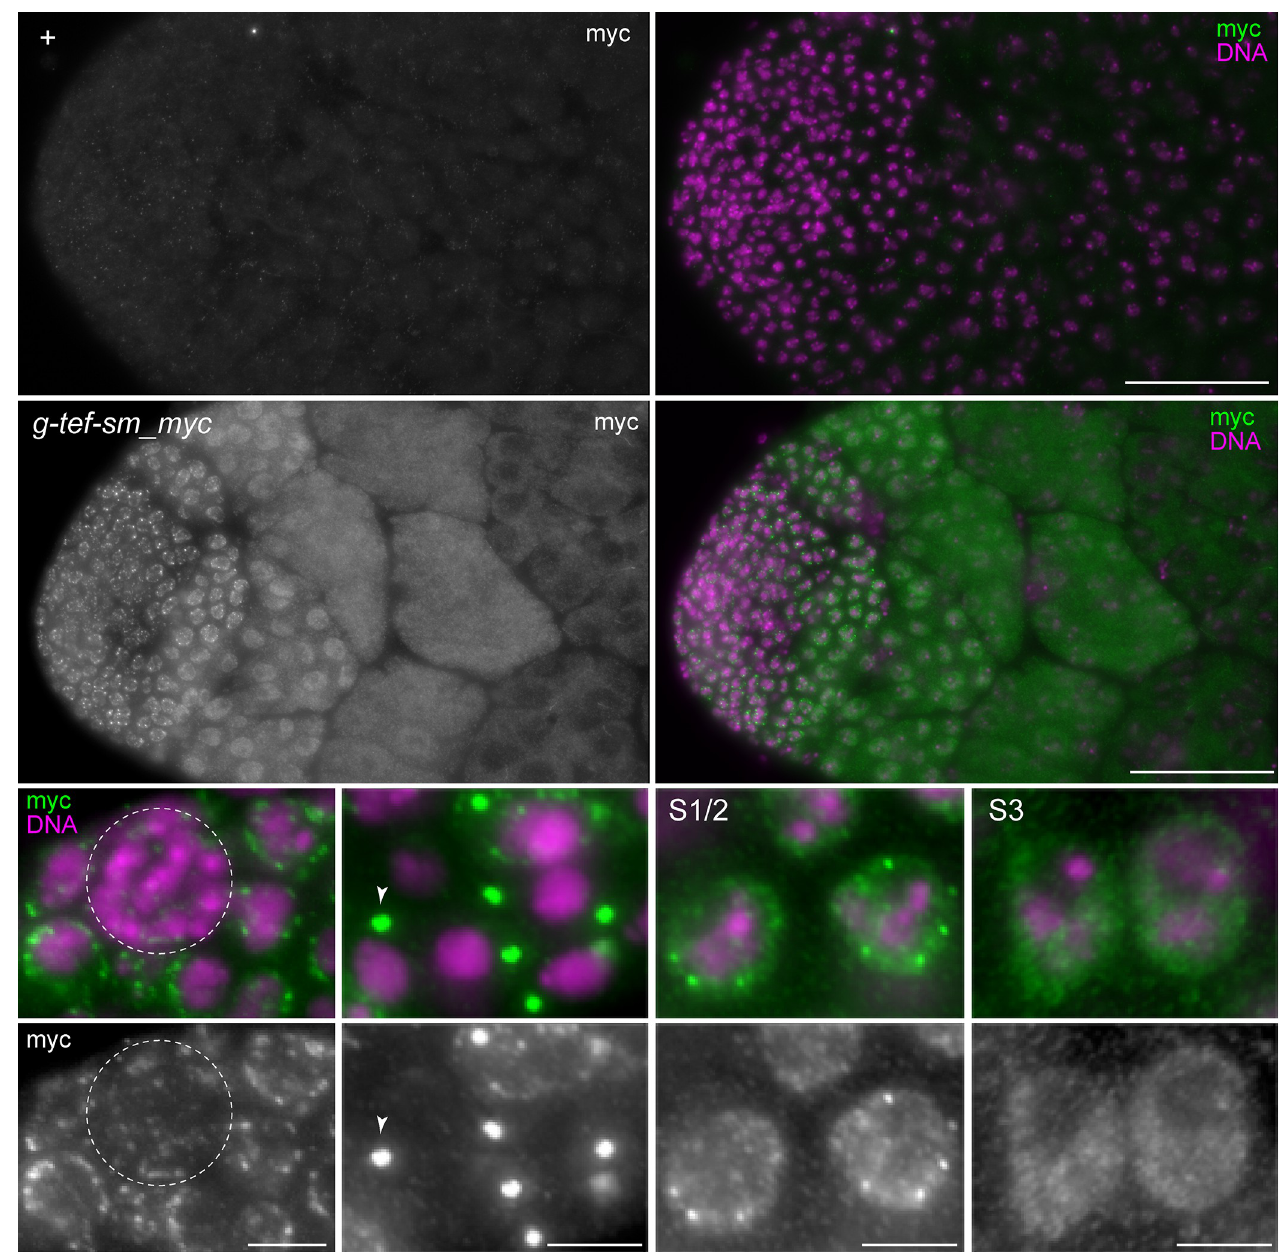
Fig 2. Expression and subcellular localization of TEF-sm_myc in testis. Flat preparations of testes isolated from either w 1118 control (+; top row) or from g- tef-sm_myc II.1 males ( g-tef-sm_myc ; middle and bottom row) were immunolabeled with anti-myc and a DNA stain. Apical testis regions are shown (top and middle row), as well as high magnification views (bottom rows) with (from left to right) stem cells around the hub (dashed circle), spermatogonial cells during telophase with labeled spindle poles (arrowhead), early spermatocytes before chromosome territory formation (S1/2) and after completion of this process (S3). Scale bars = 50 μ m (top and middle row) and 5 μ m (bottom row). indistinguishable results were obtained with two distinct transgene insertions (II.1 and III.1). The strongest anti-myc signals in these testes were observed in early S1/2 spermatocytes before chromosome territory formation within the cell nucleus (Fig 2). These strongest signals were granular at the nuclear periphery, where DNA staining was absent. In regions with DNA